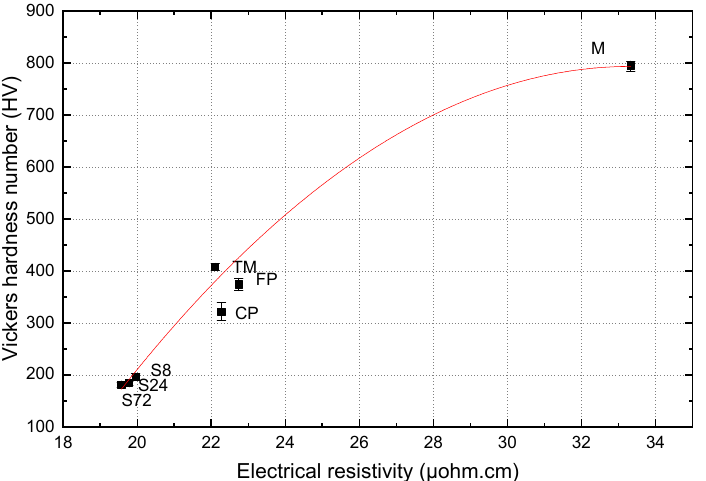
Figure 10. Correlation between resistivity measurements and Vickers hardness of the AISI 1080 steels heat-treated at different conditions, where FP = fine pearlite; CP = coarse pearlite; S8/S24/S72 = spheroidite annealed for 8, 24, and 72 h, respectively; M = martensite; and TM = tempered martensite microstructures.